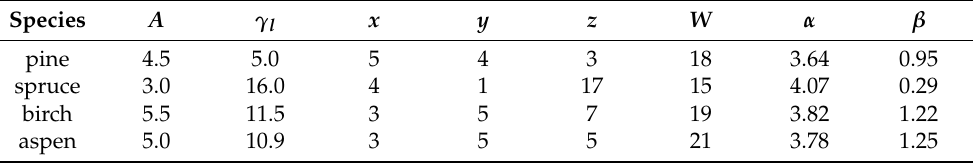
Table 1. Species-specific coefficients used for the calculation of competition indices. Species A γ l x y z W α β pine 4.5 spruce 3.0 birch aspen